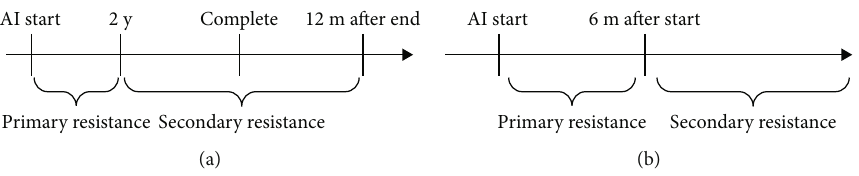
Figure 1: De fi nition of primary and secondary AI resistance in cases of AI as adjuvant therapy (a) and AI for metastatic breast cancer (b). Table 1: Patient